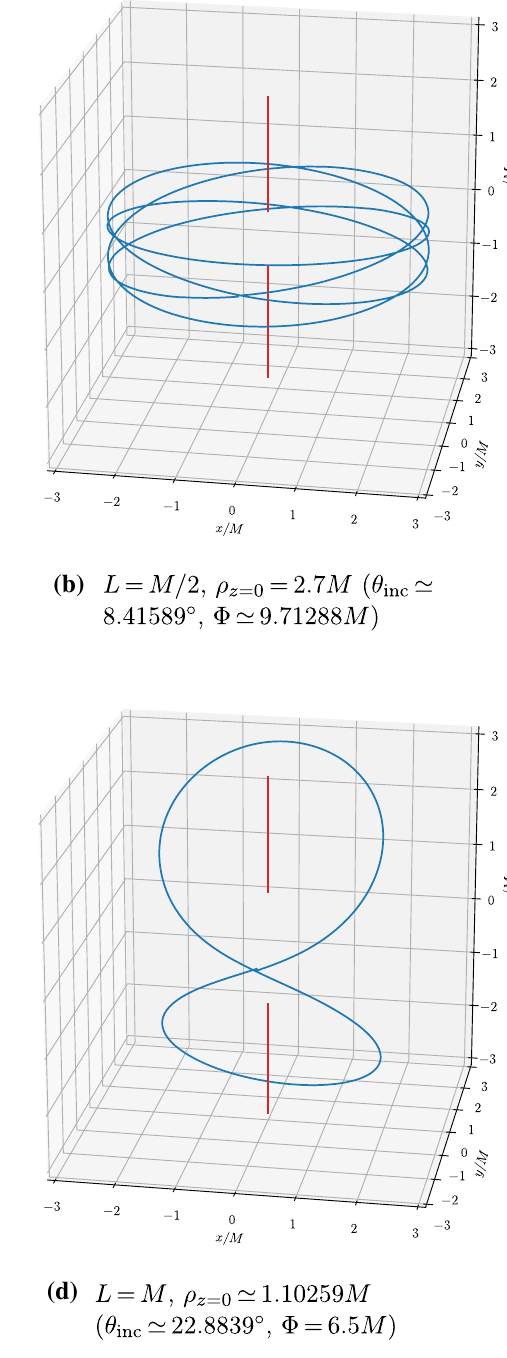
Fig. 8 Examples of Class A FPOs for four different values of L and ρ z = 0 as indicated. The orbits start at the equatorial plane in all four plots, and terminate after the interval (cid:10)φ = 8 π for a and b , and 4 π for c and d will become almost vertical. However, as the lowest point of the orbit nears the conical singularity between the two rods, a deflection of the type described at the end of Sect. 6.1